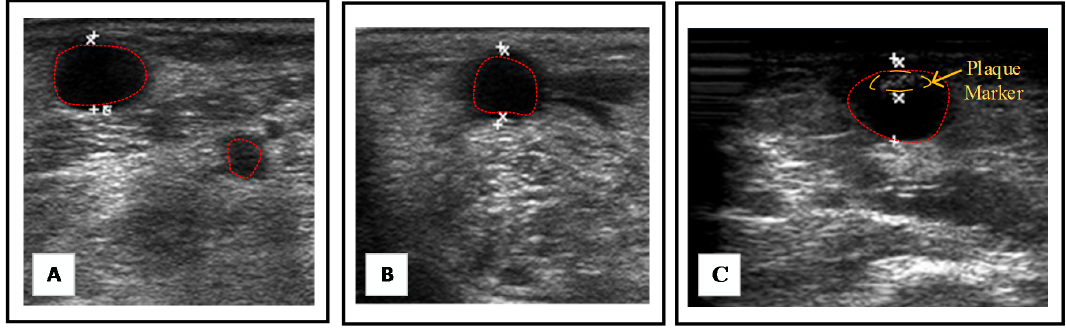
Figure 6. Initial contour of vessel section was created by ACM from ( A ) linear scan; ( B ) circle scan; and ( C ) was an image, which was adjusted contour and marked as plaque by clinicians.